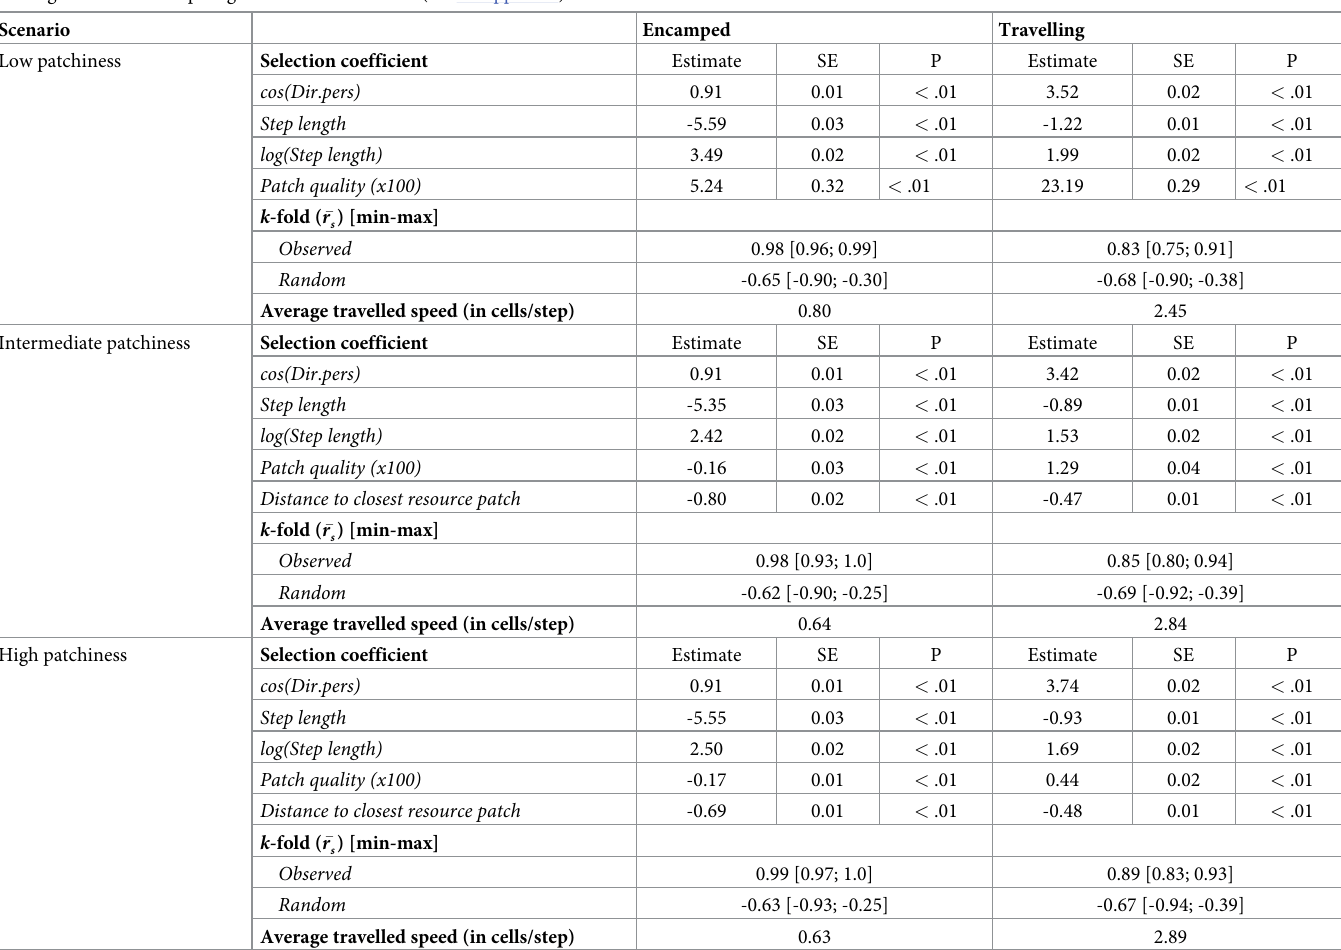
Table 2. State-specific selection coefficient estimates along with their standard-error (SE) and associated P-value (P) of the HMM-SSF used to predict simulated animal movements according to encamped or travelling mode, in landscapes with varying levels of patchiness. For each scenario, 500 trajectories were simulated from multi-state correlated random walk and used to estimate population level state-specific selection coefficients. Means ( � r 100 Spearman rank correlation are reported for each movement mode and both observed and random steps. Average travelled distances were calculated using step length and log-transformed step length coefficient estimates (see S1